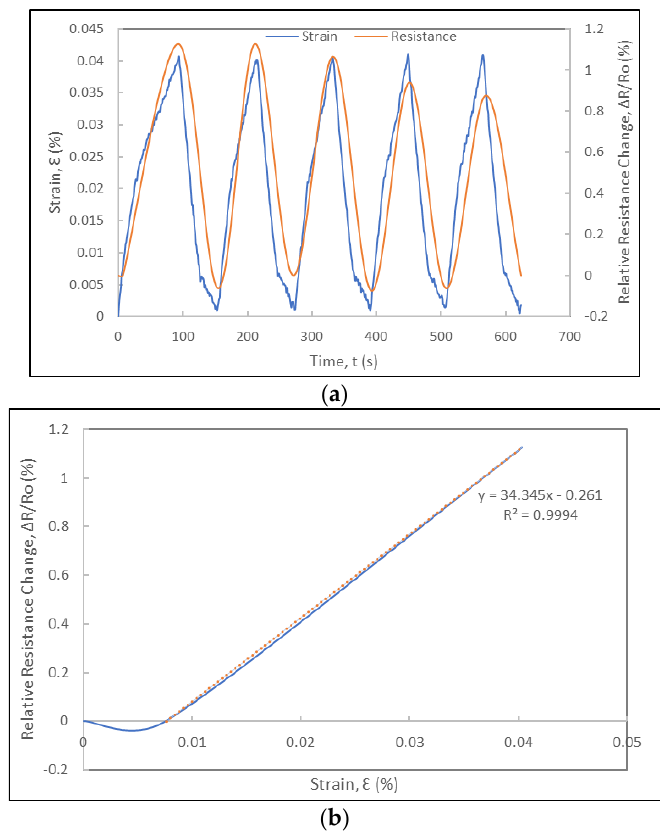
Figure 8. Electromechanical response of a foil strain gauge prototype under cyclic loading at a displacement rate of 300 µ m/min: ( a ) Strain and relative resistance change histories during five loading-unloading cycles; ( b ) Relative resistance change versus strain curve of first loading cycle and corresponding gauge factor.